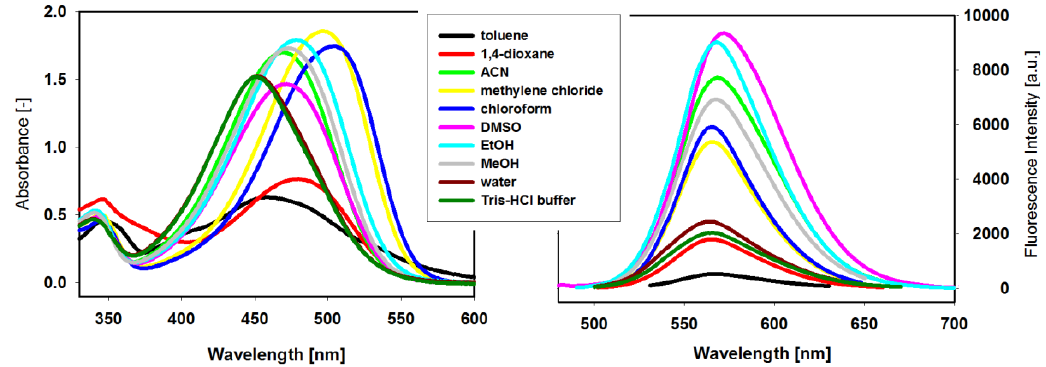
Figure 2. Absorption ([3] = 3.6 × 10 − 5 M) and fluorescence ([3] = 2.2 × 10 − 6 M) spectra of the dye 3 in selected organic solvents and aqueous solutions at room temperature (λ ex = Abs. λ max ).